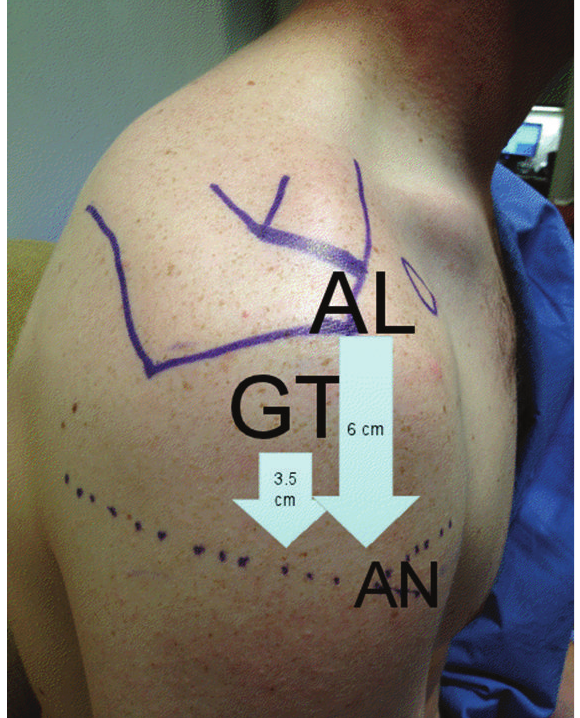
Figure 4: The axillary neurovascular structure (AN) can be palpated as a cordlike structure within the anterior deltoid raphe located an average of 3.5 cm from the greater tuberosity (GT) prominence or 6 cm from the anterolateral (AL) border of the acromion, the latter of which is more reliable in the setting of proximal humerus